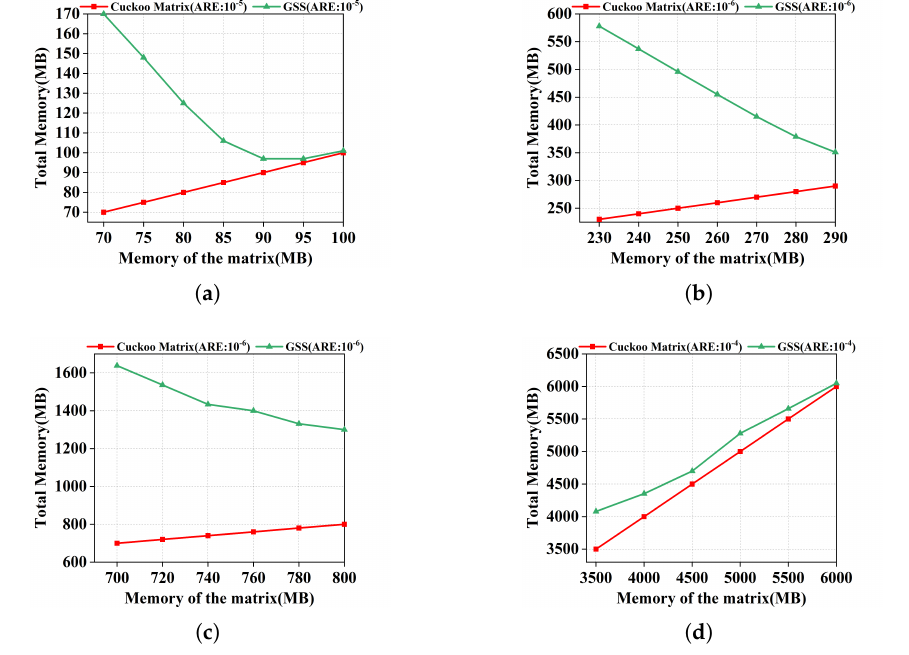
Figure 12. Memory consumption. ( a ) Skitter. ( b ) DBLP. ( c ) Orkut. ( d )